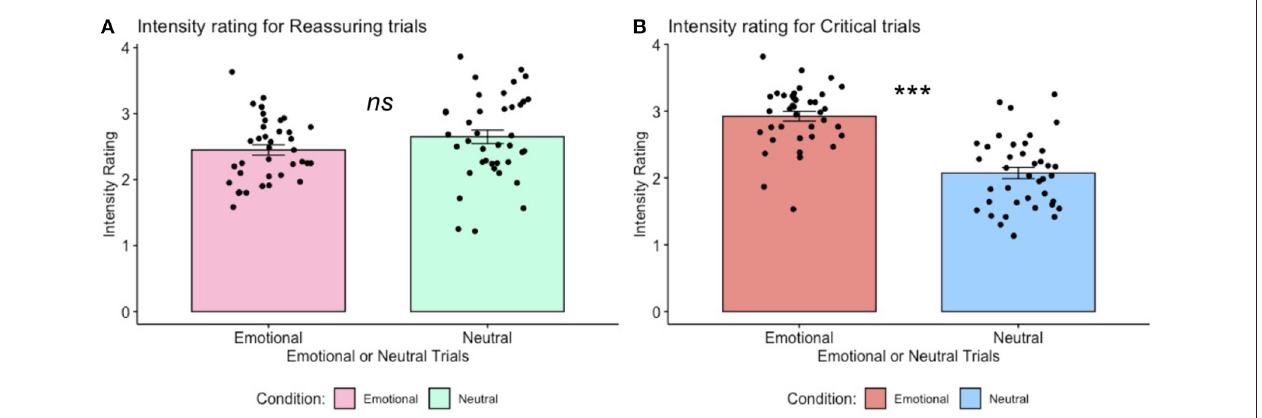
FIGURE 3 | Trial-by-trial ratings of intensity for self-critical and reassuring trials. (A) . Intensity ratings for self-reassuring trials, across emotional vs. neutral stimuli. One-sample paired t -test returned non-significant, p > 0.05, ns. (B) . Intensity ratings for self-critical trials, across emotional vs. neutral stimuli. For these self-critical trials, one-sample paired t -tests revealed self-report ratings of intensity for emotional stimuli were greater than intensity ratings for neutral stimuli, p < 0.001. Error bars indicate standard